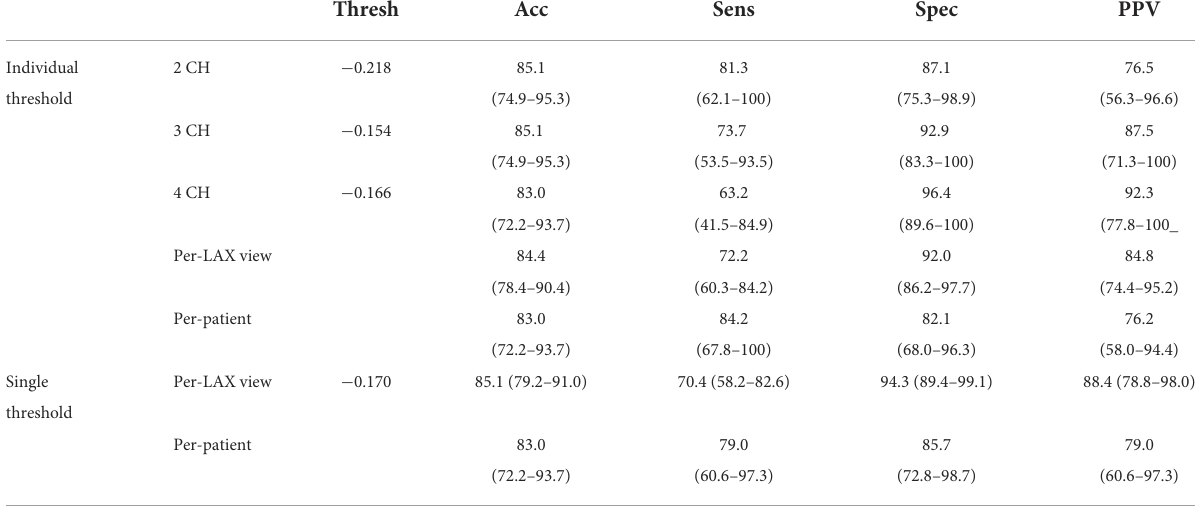
TABLE 3 Performance of LS in the testing cohort using the curve-fitting